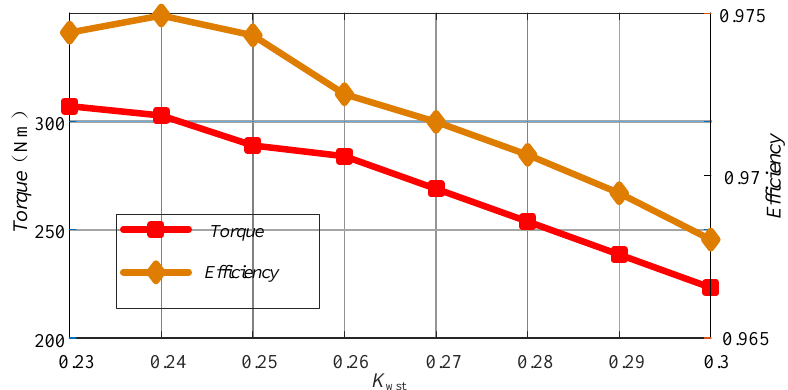
Figure 5. Relationship between torque, efficiency, and K wst of FSPM generator.